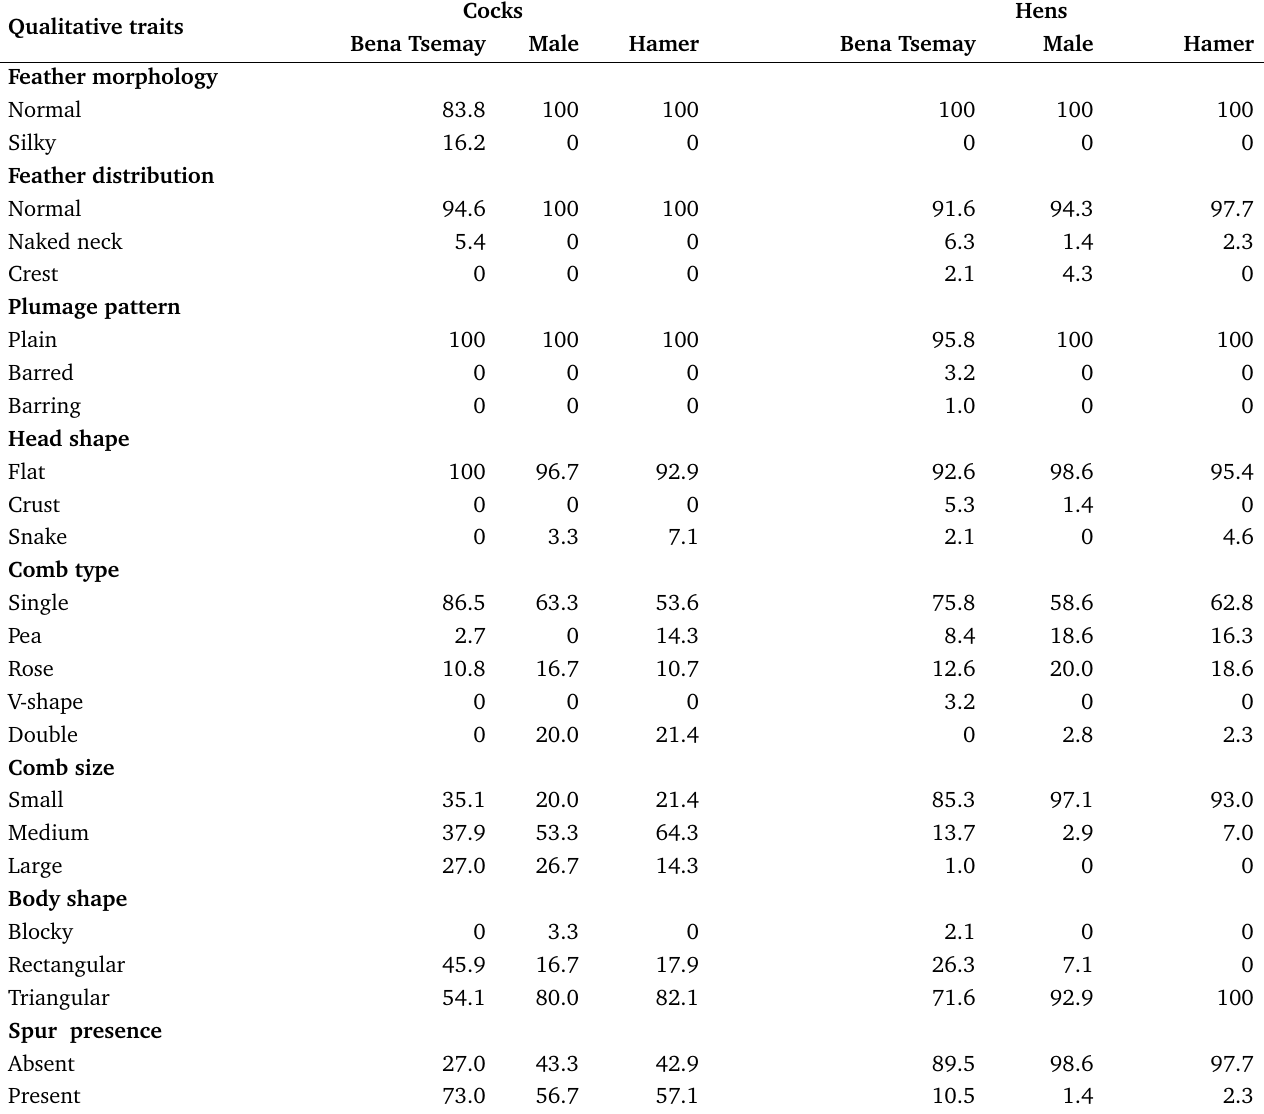
Table 6. Percentages for the qualitative characteristics of the chicken populations from different